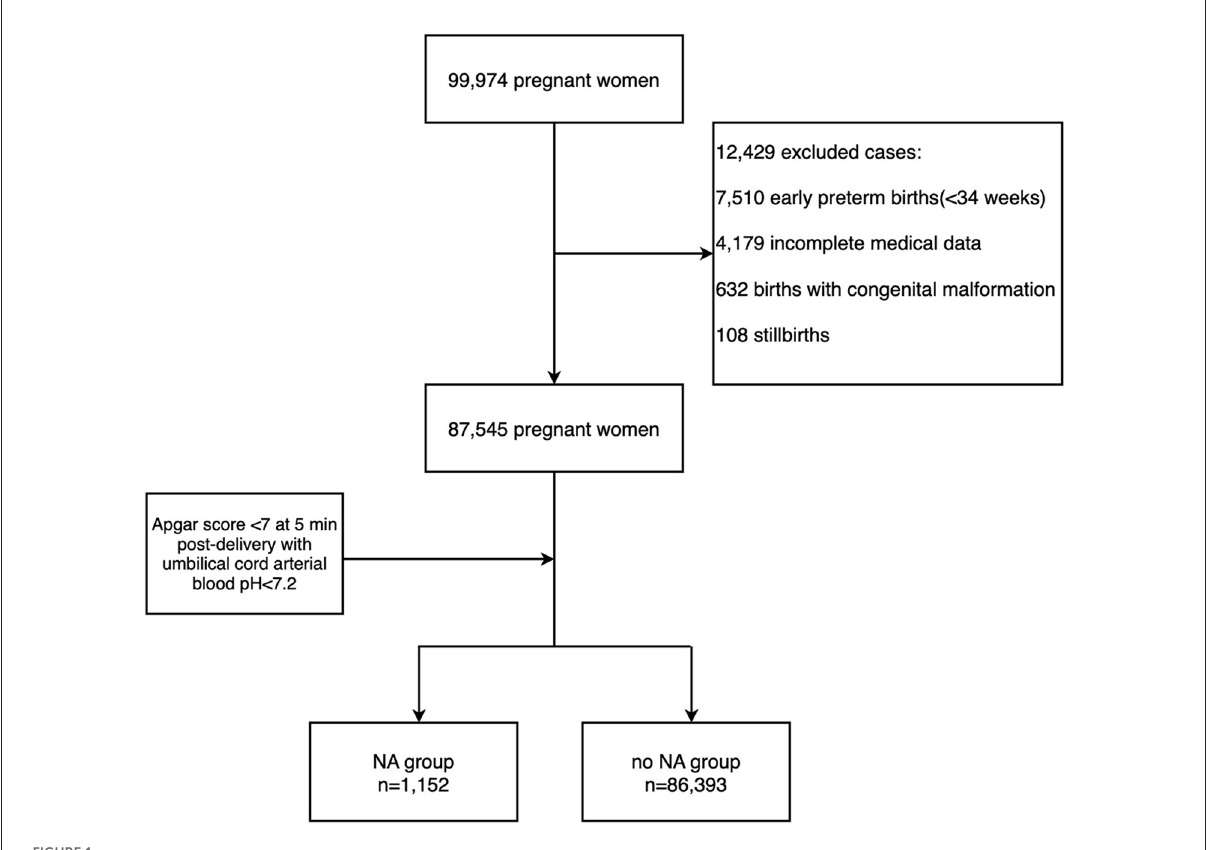
FIGURE1 Flowchart of the included